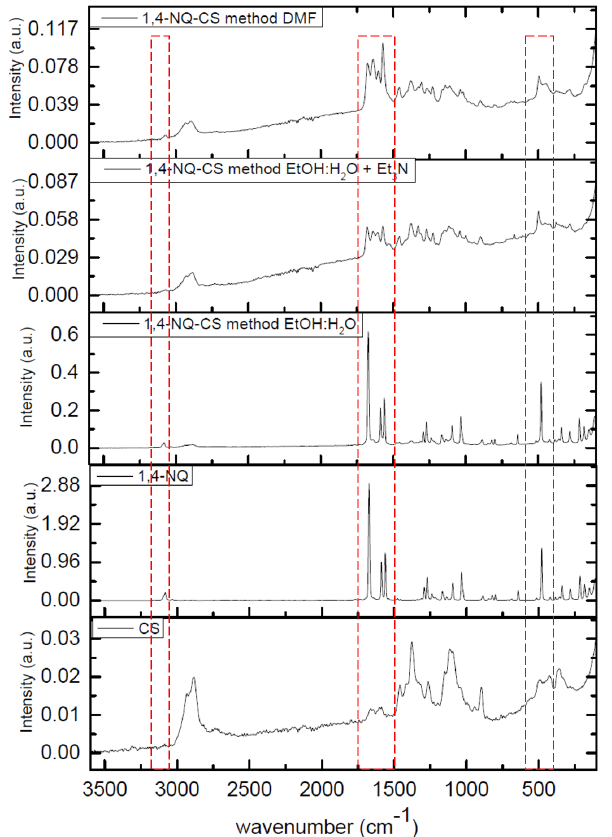
Figure 12. Experimental RAMAN spectra of 1,4-NQ-CS obtained by the DMF method; chitosan (CS); 1,4-NQ-CS obtained by the EtOH:H 2 O + Et 3 N method; 1,4-NQ-CS obtained by the EtOH:H 2 O method; 2,3-dichloro-1,4-naphthoquinone (1,4-NQ), and chitosan (CS).